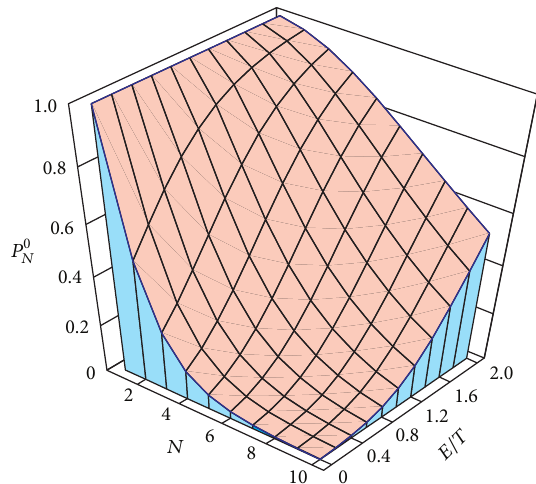
Figure 7: The probability of phase transition without the formation of the domain walls 𝑃 0 𝑁 as a function of the number of disconnected subregions 𝑁 and the ratio of the domain wall energy to the phase transition temperature 𝐸/𝑇